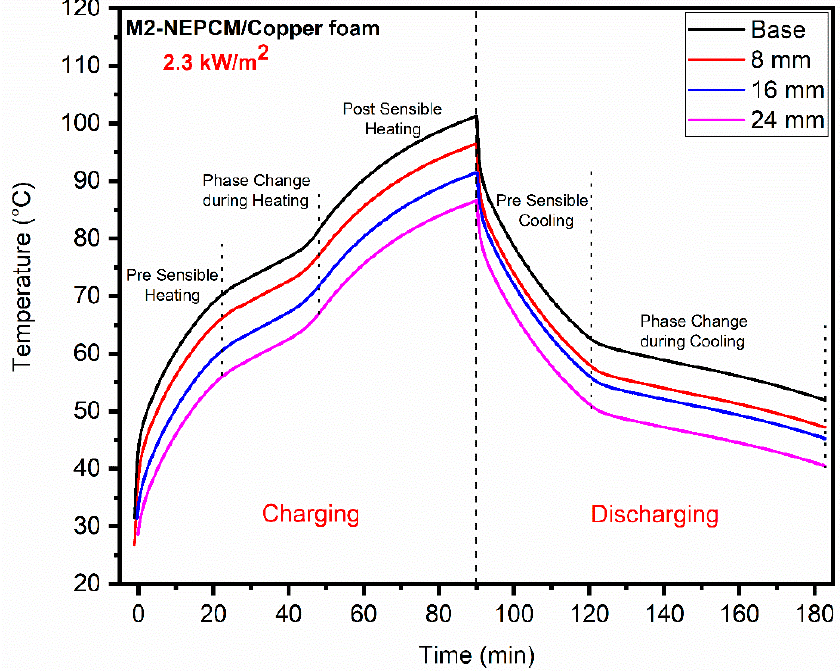
Figure 16. Spatial temperature distribution within heat sink filled with M2-NEPCM/copper foam at 2.3 kW/m 2 .